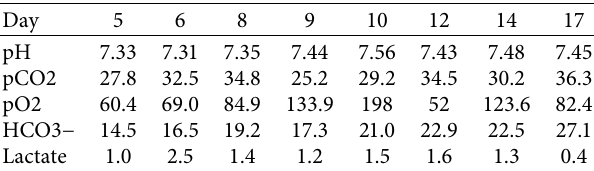
Table 2: trend of arterial biochemical